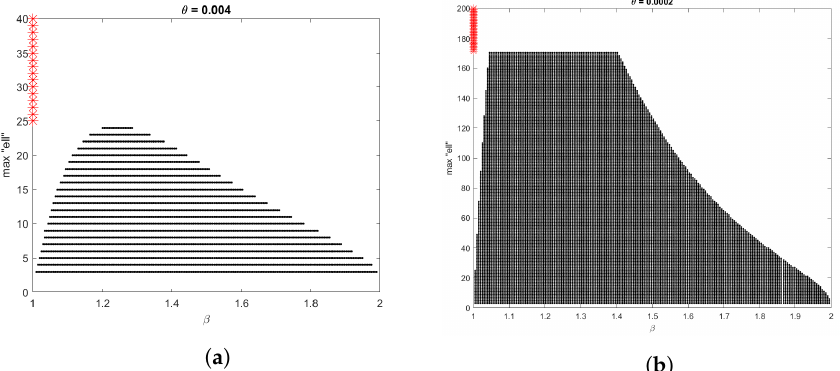
Figure 2. Representation of D (cid:96) , θ for different values of (cid:96) and θ . ( a ) Representation of D (cid:96) ,0.004 for (cid:96) ∈ N 40 . ( b ) Representation of D (cid:96) ,0.0002 for (cid:96) ∈ N 200 3